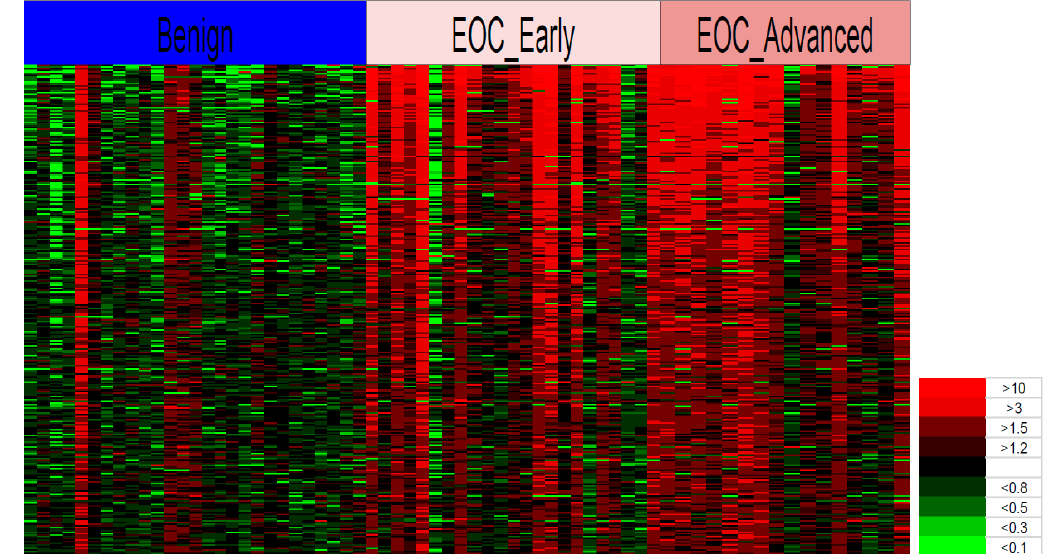
Figure 3. Heat map of glycopeptides in the blood sera of early-stage EOC, advanced-stage EOC, and non-cancer patients. The Y-axis represents 300 individual glycopeptides in the MS spectra and the X-axis represents the individual patients in the cancer and non-cancer groups. The spectral colors in the matrix represent the ratio level of glycopeptide peaks in the individual compared to the average level in the non-cancer group ranging from the brightest green (<0.1) to the brightest red (>10). Abbreviation: EOC, epithelial ovarian cancer.